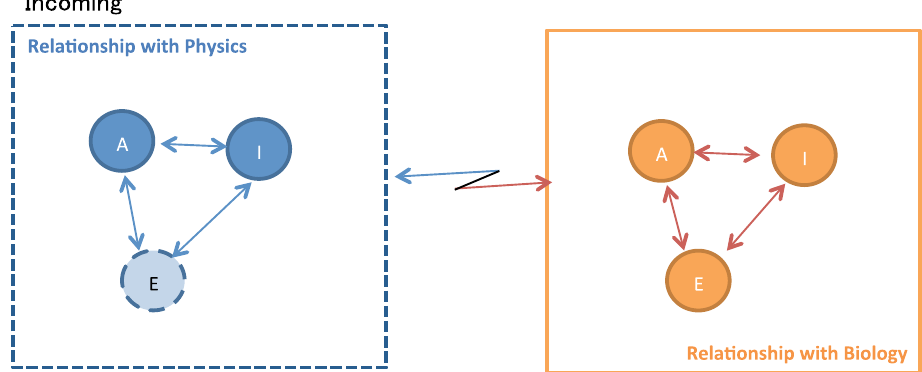
FIG. 5. Violet ’ s incoming relationship with physics is in contrast with her relationship with biology. The jagged arrows represent tensions between the two disciplinary relationships as we have conceptualized the